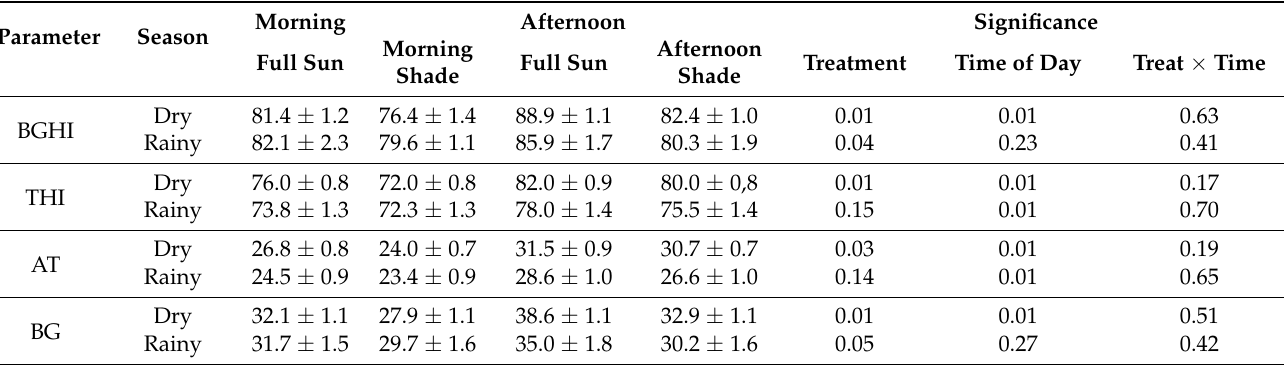
Table 1. Black globe humidity index (BGHI), temperature and humidity index (THI), air temperature (TA), and black globe (BG) temperature ( ◦ C) obtained from the full sun and shade environment with Integrated Crop-Livestock-Forestry (ICLF) in the morning and afternoon, during the dry and rainy